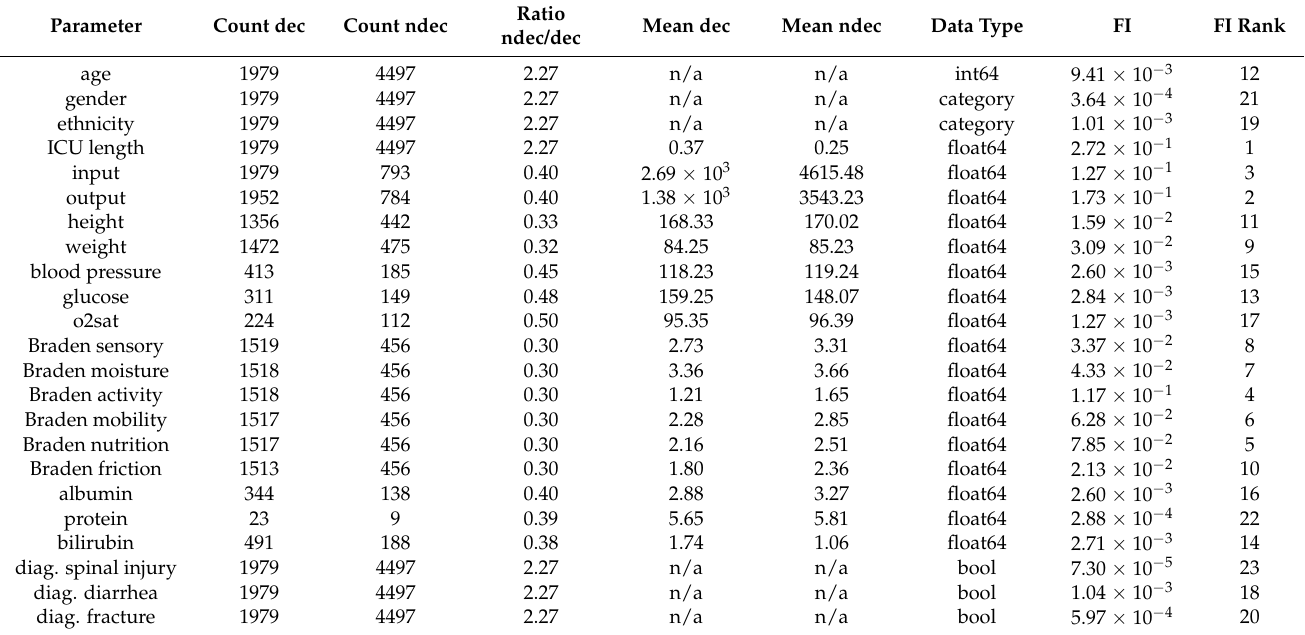
FI, feature importance; dec, patients with PU; ndec, patients without